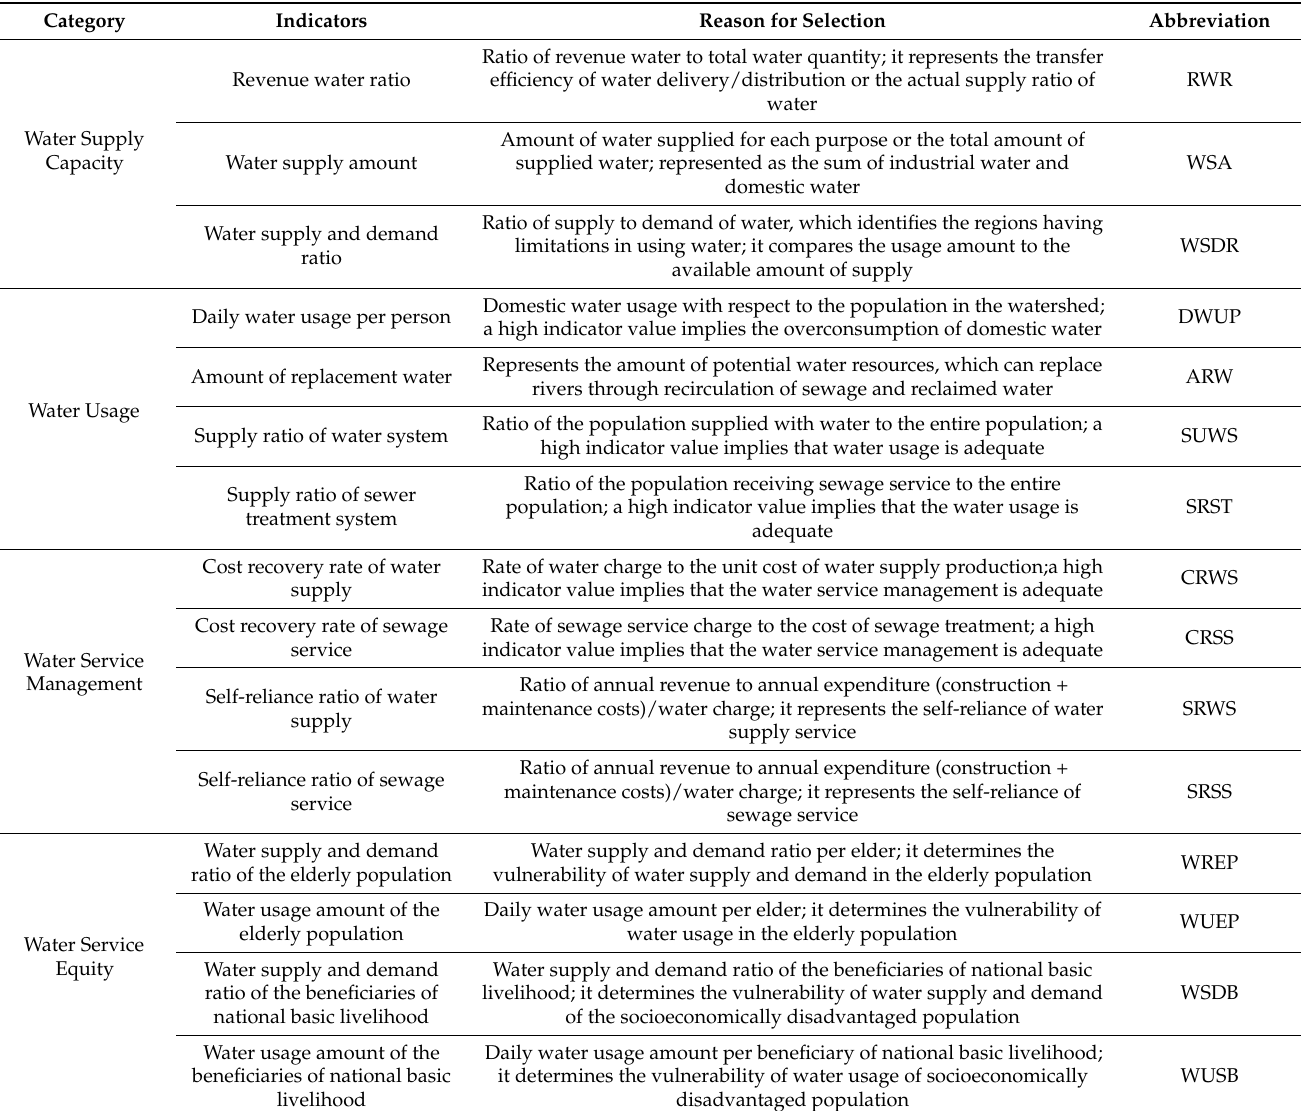
Table 2. Reasons for selection of water social service